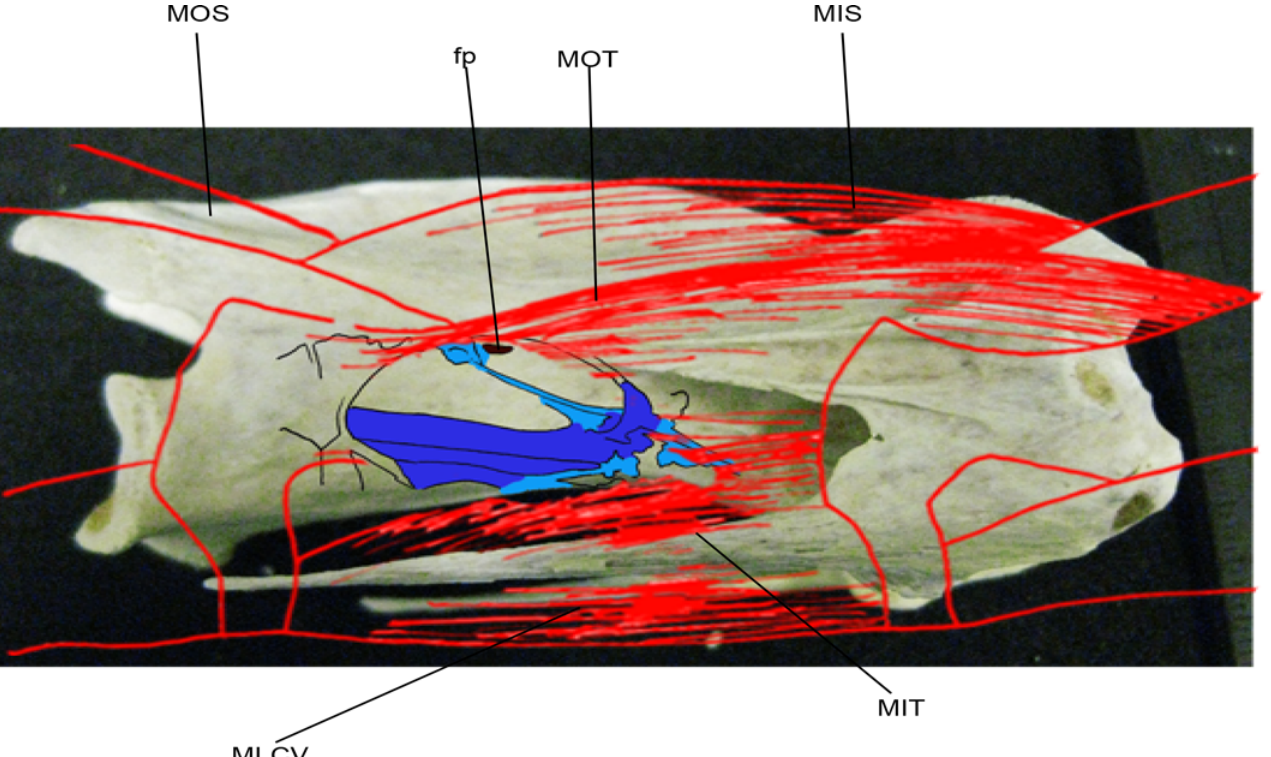
Fig 2. Schematic representation of air sac complex with its associated muscles. Right lateral view of a Struthio camelus (ostrich) mid-cervical vertebra, showing a local fraction of the air sac diverticular complex and the muscle groups (red) associated with it and the vertebra. The black lines represent the various borders of the diverticular membrane extensions; the purple shows the air sac's lateral vertebral diverticulum along the corpus; the light blue depicts the membranes that extend from the diverticulum, anchoring on the corpus and invading the brown foramen pneumaticum . Abbreviations: fp